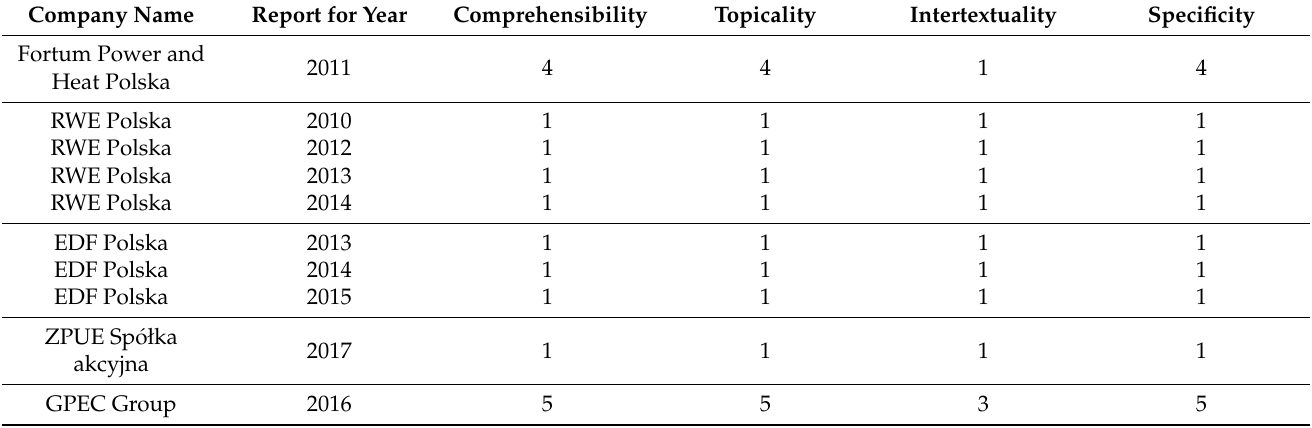
Table 8. Assessment of the QMS information included in energy companies’ non-financial